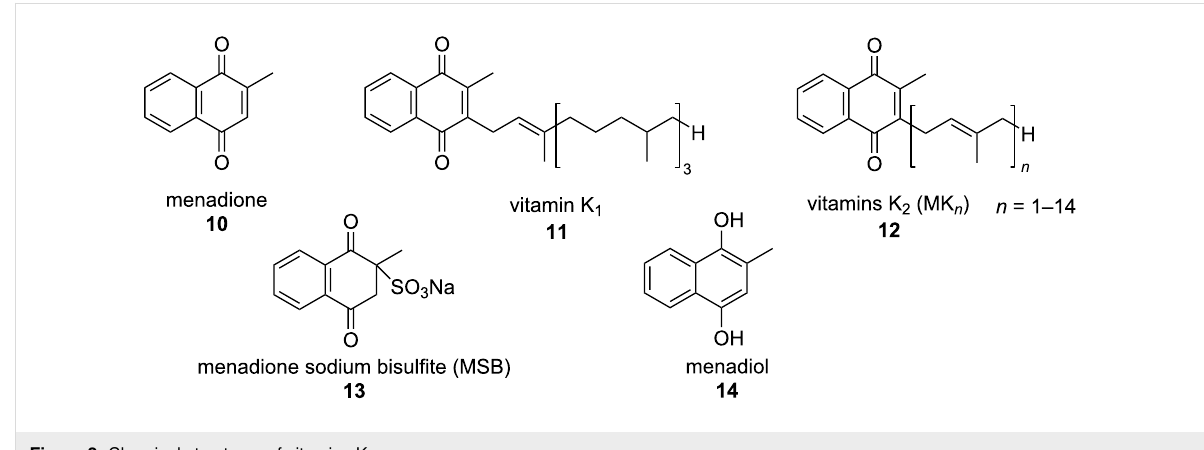
Figure 2: Chemical structures of vitamins